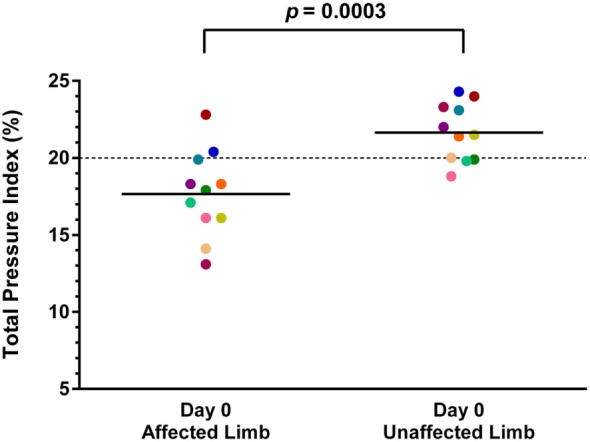
A statistically significant difference was found between the treated limb and contralateral limb total pressure index percent (TPI%) at day 0 (p = 0.0003) (solid line, mean; dotted line, normal TPI%).